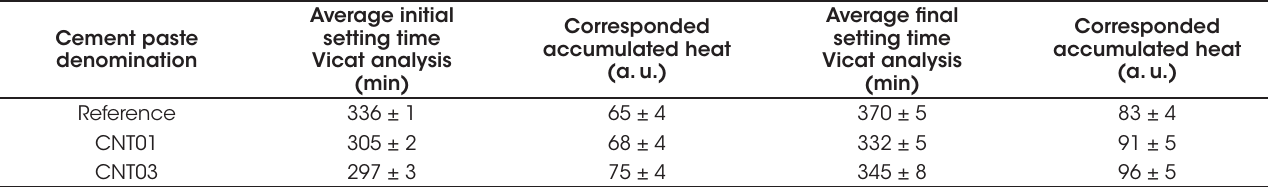
Vicat analysis: average initial and final setting times and corresponding evolved accumulated heat for each cement paste composition Cement paste denomination